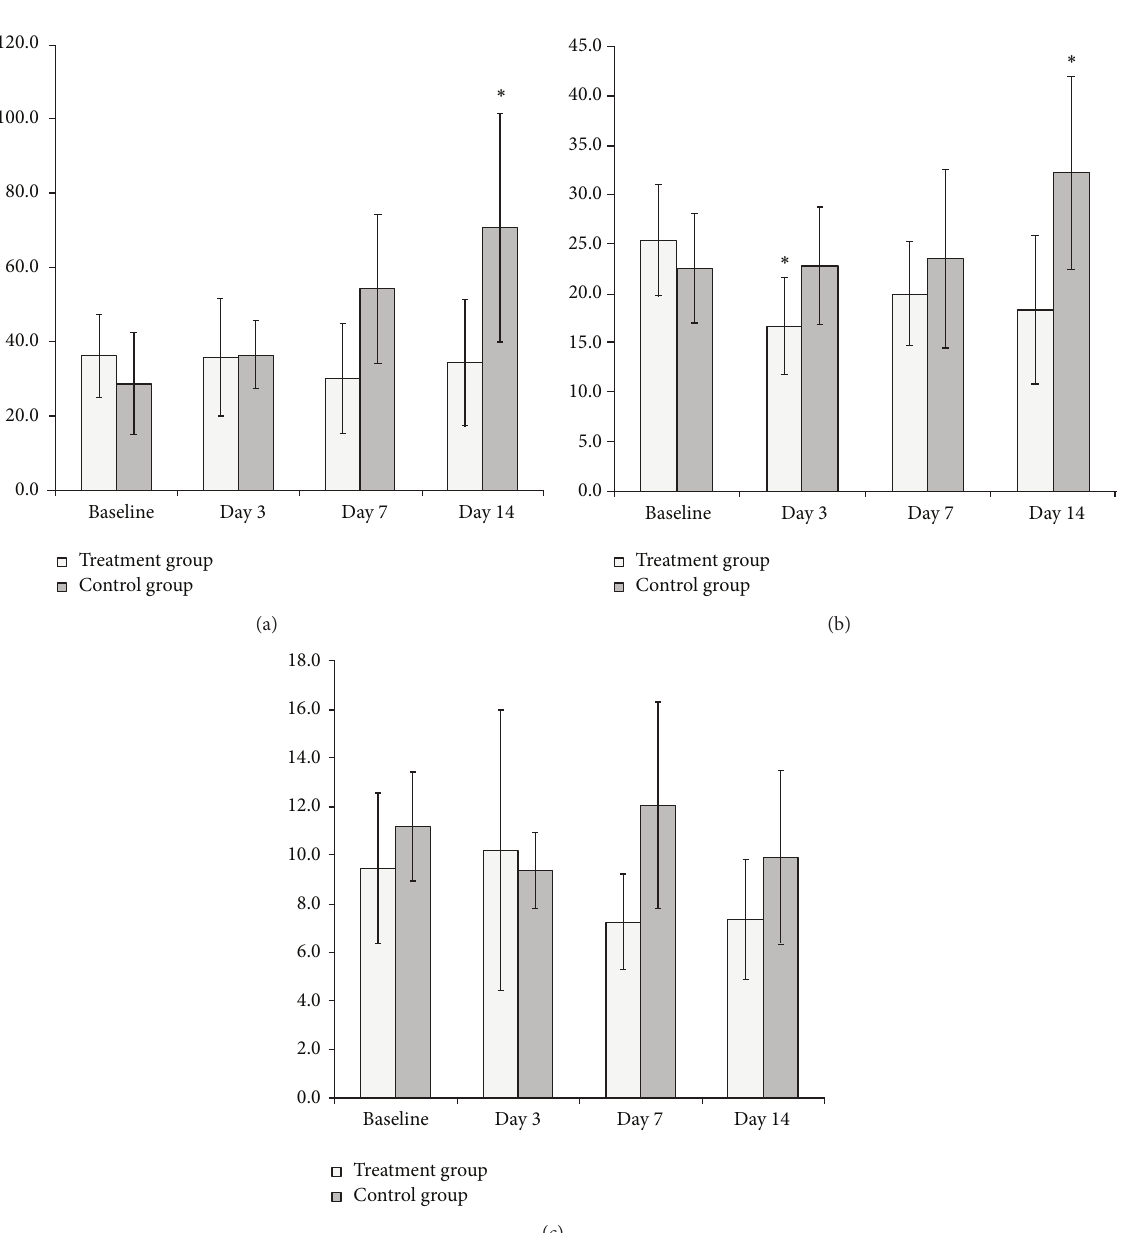
Figure 2: Averaged (a) BF, (b) BV, and (c) PS before and at different time points after bevacizumab therapy. In the control group, BF increased gradually and both BF and BV on day 14 demonstrated significant increases. In the treatment group, a significant decrease in BV on day 3 was observed. ∗ is significant change compared to the baseline, BF is blood flow, BV is blood volume, and PS is permeability surface area